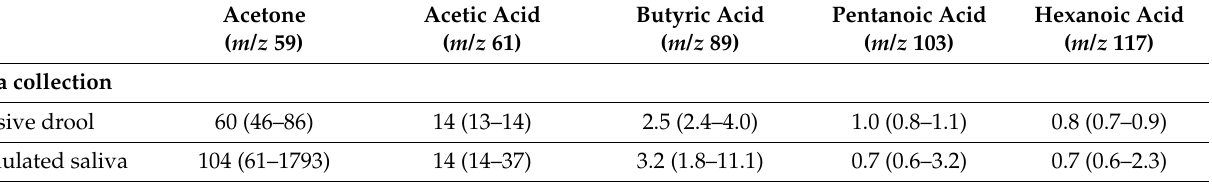
Table 1. Influence of sampling methodology on the selected salivary VOC concentrations